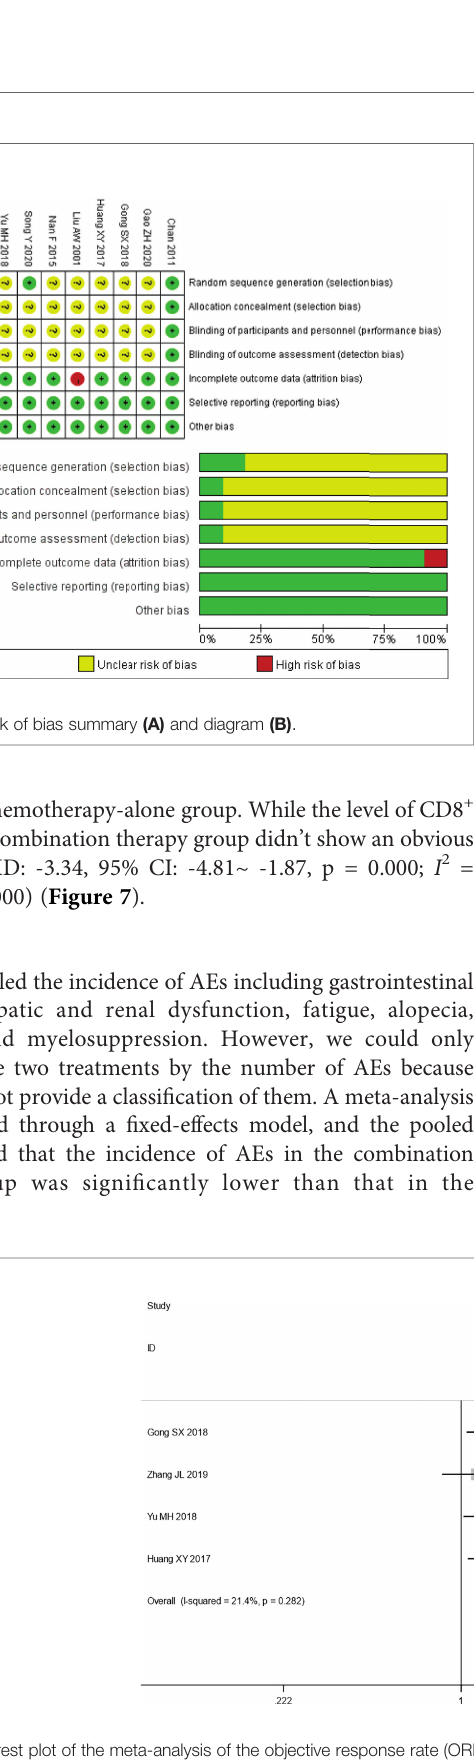
FIGURE 3 | Forest plot of the meta-analysis of the objective response rate (ORR) between the intervention group and the control